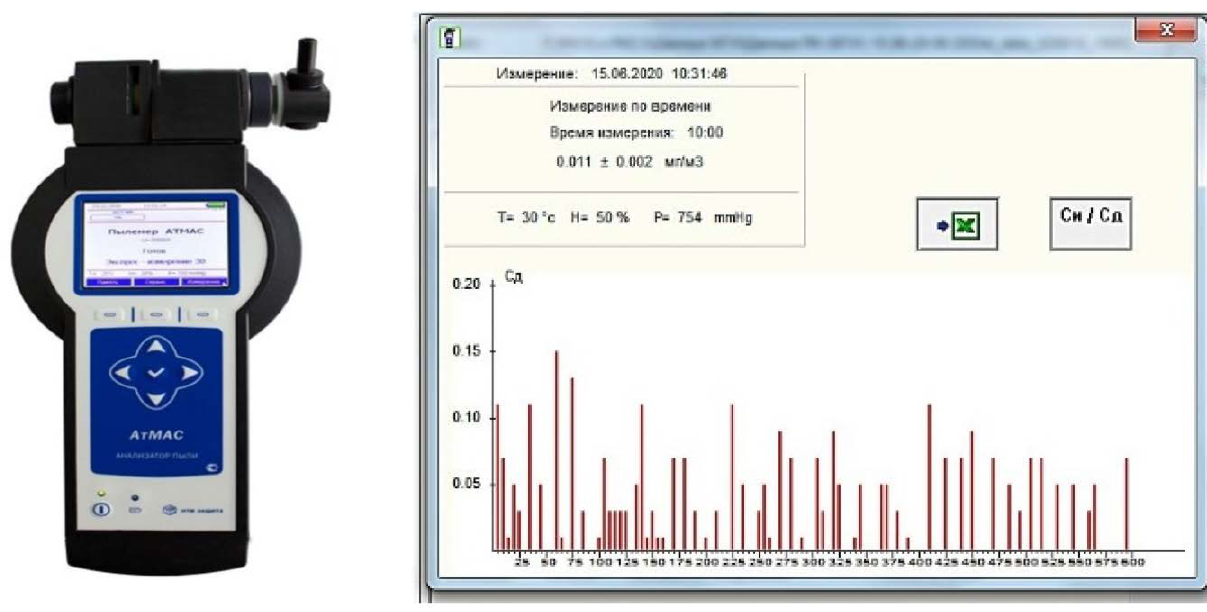
Figure 2. Dust meter